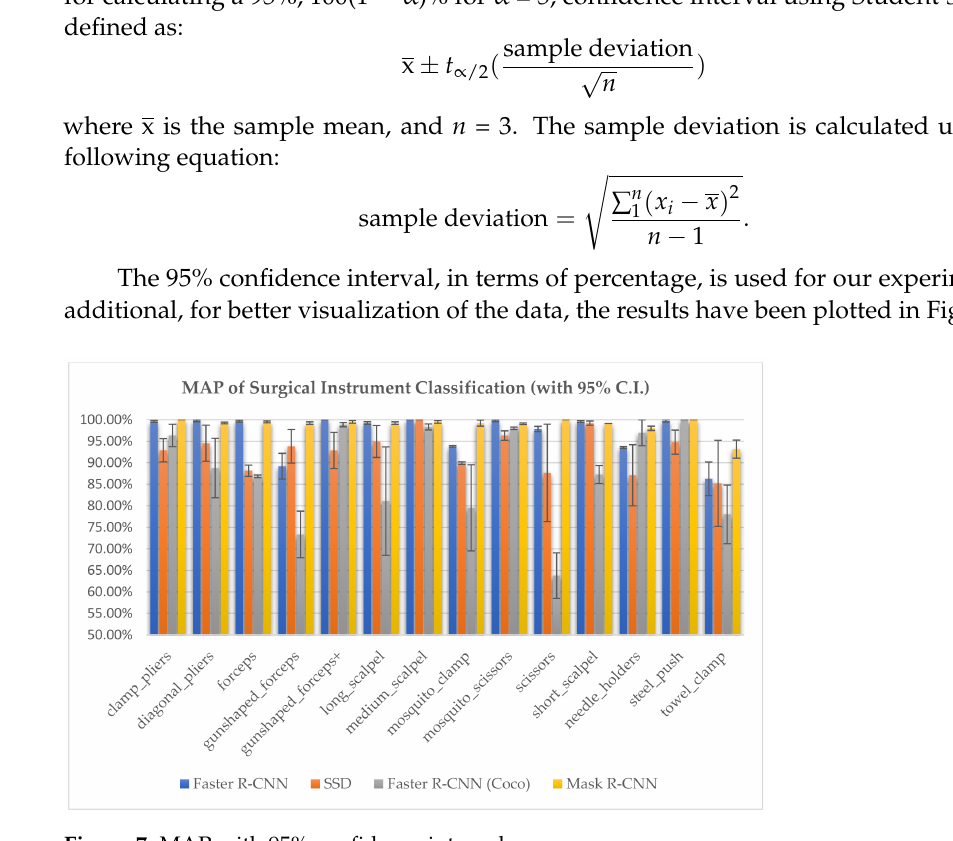
Figure 7. MAP with 95% confidence